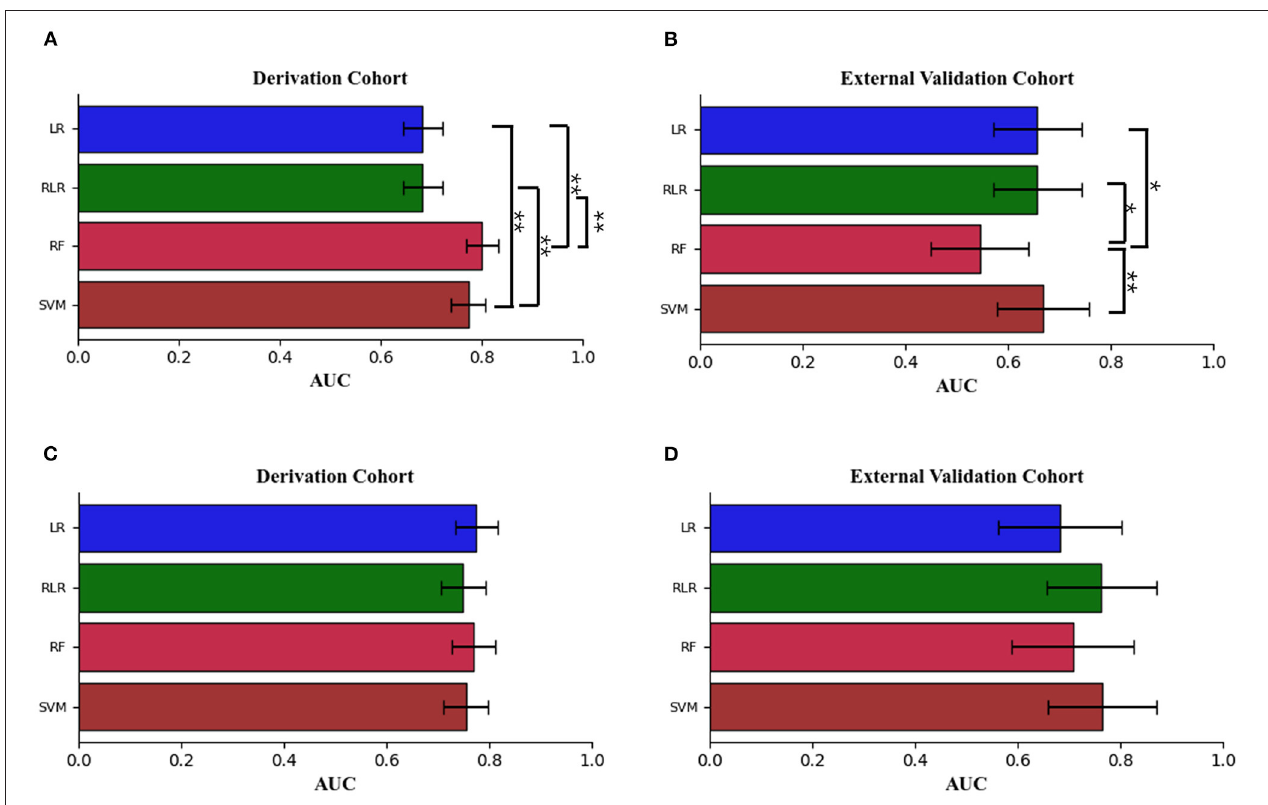
FIGURE 3 | The means ± 95% CI of the receiver operating characteristic area under the curve (AUC) for models 1 and 2 are displayed as bar graphs using the derivation cohort data (A,C) , and the validation cohort data (B,D) . For the derivation cohort data, there were significant differences between random forest [RF], support vector machine [SVM] and logistic regression without regularization [LR], regularized logistic regression [RLR] in model 1. For the external validation cohort data, there were significant differences between the random forest [RF] and the other three machine learning methods in model 1. For the derivation and external validation cohort data, the Delong test with Bonferroni correction was used. LR indicates logistic regression without regularization; RF, random forest; RLR, regularized logistic regression; and SVM, support vector machine. * P < 0.01, ** P < 0.001.